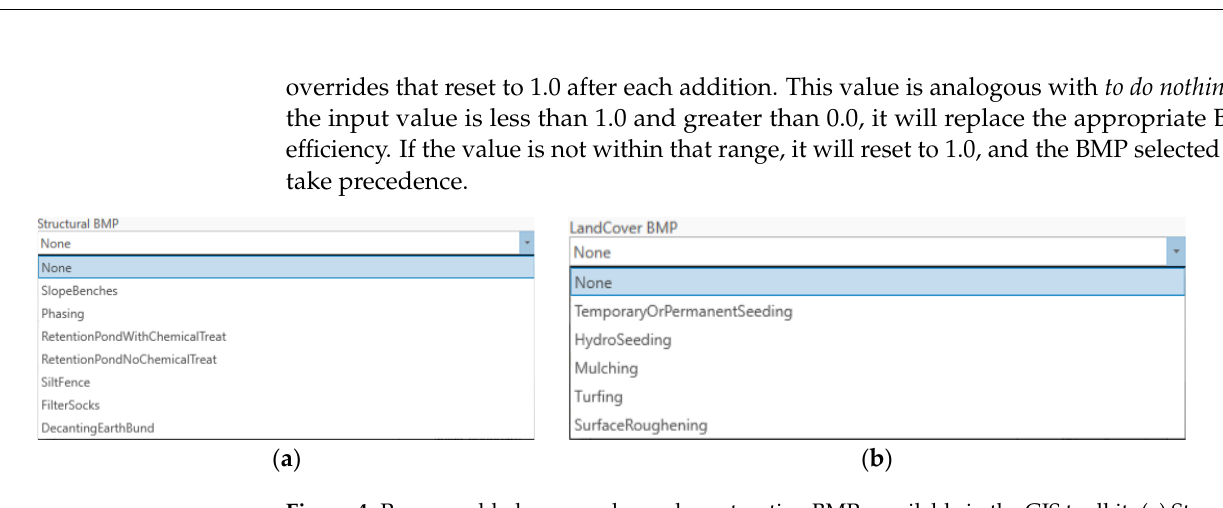
Figure 4. Pre-assembled commonly used construction BMPs available in the GIS toolkit: ( a ) Structural BMPs, and ( b ) Landscape BMPs.